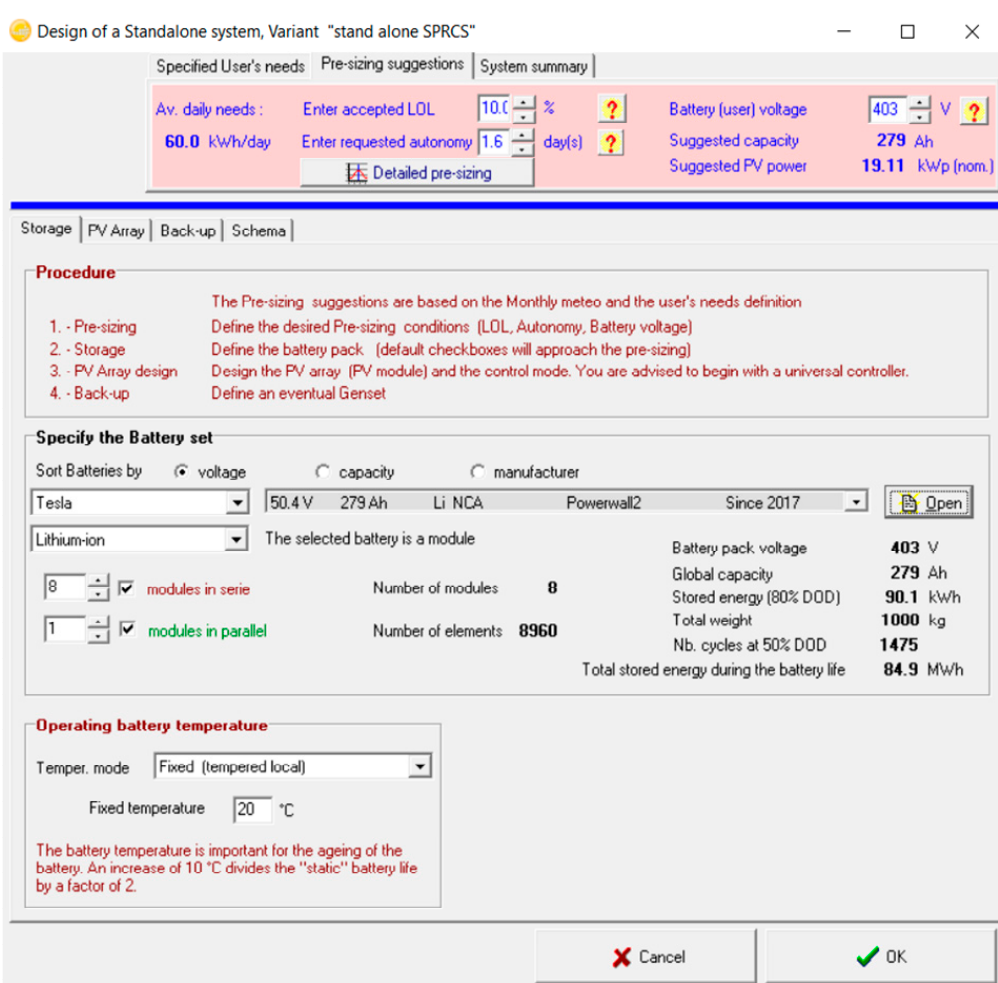
Figure 10. Designing of on-board storage system for SPRCS.